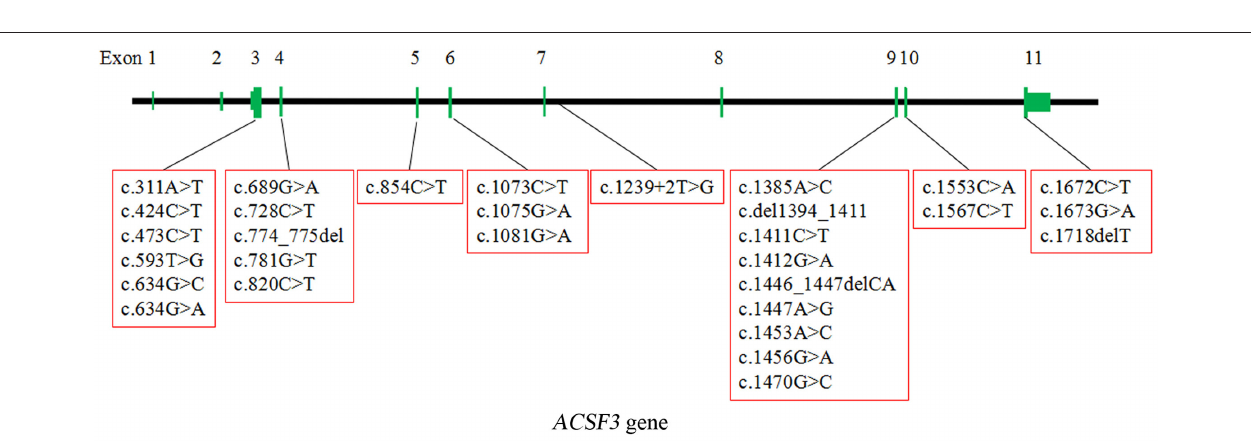
FIGURE 5 | The localization of 30 homozygous or compound heterozygous variants in ACSF3 reported worldwide (except for a Chr16:87441993:89171912 deletion spanning ACSF3 ). The types of the variants include missense, nonsense, deletion, frameshift, and splice site variants. The most common type is missense.